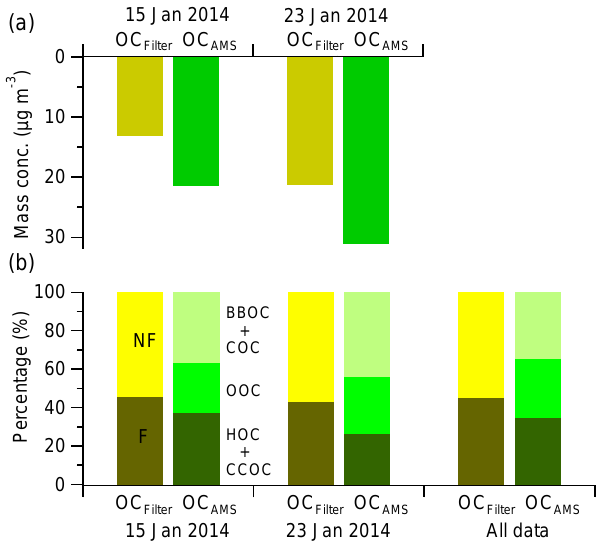
Figure 12. The comparisons of (a) OC concentration measured by filter sample (OC Filter ) and AMS (OC AMS ) on 15 and 23 January 2014 and (b) the non-fossil (NF) and fossil (F) carbon fraction mea- sured by 14 C and OC components in AMS.